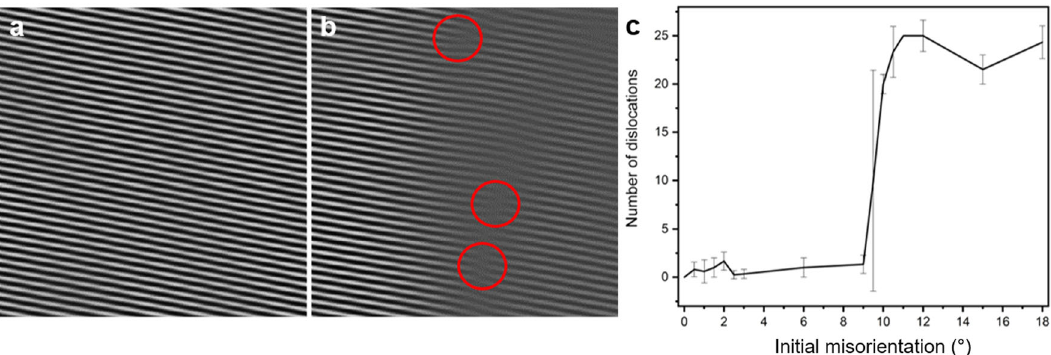
Fig. 4 Number of dislocations along the grain boundary. Real-space images of a single density mode 38 , in the region where QCs collide, taken from the last frame in MD simulation (~ 2.5 × 10 7 simulation timesteps) with a 3° and b 15° initial misorientations. Dislocations are highlighted with red circles. a and b are cropped to provide a magni fi ed view from the images that represent full volume. c Relationship between the initial misorientation and number of dislocations along the grain boundary in the coalesced structure. We fi nd that there are few dislocations (if any) at low ( θ ≲ 9. 5°) initial misorientation, since two QCs can rotate toward θ = 0° (cf. a ). Conversely, there are many dislocations when two QCs cannot minimize the misorientation between them. The error bars were calculated from multiple dislocation analyses to retain consistency of our approach.